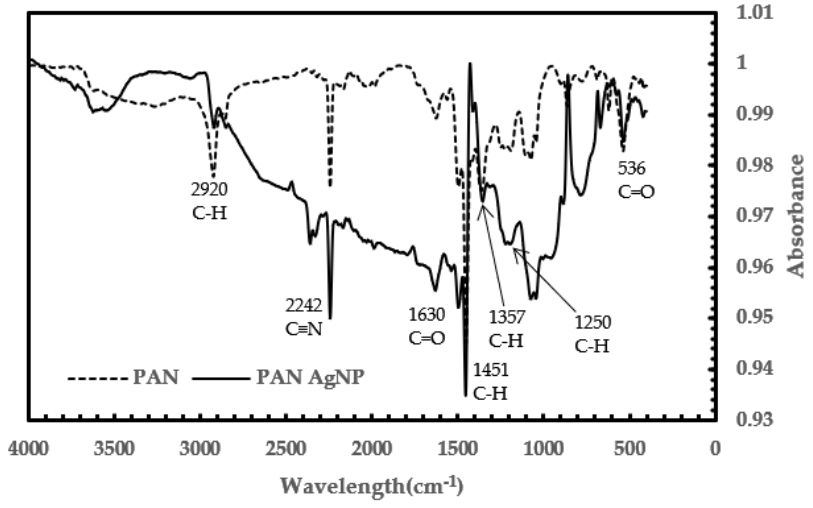
Figure 4. Comparison of Fourier transform infrared (FTIR) spectra of PAN and PAN with AgNP membranes.